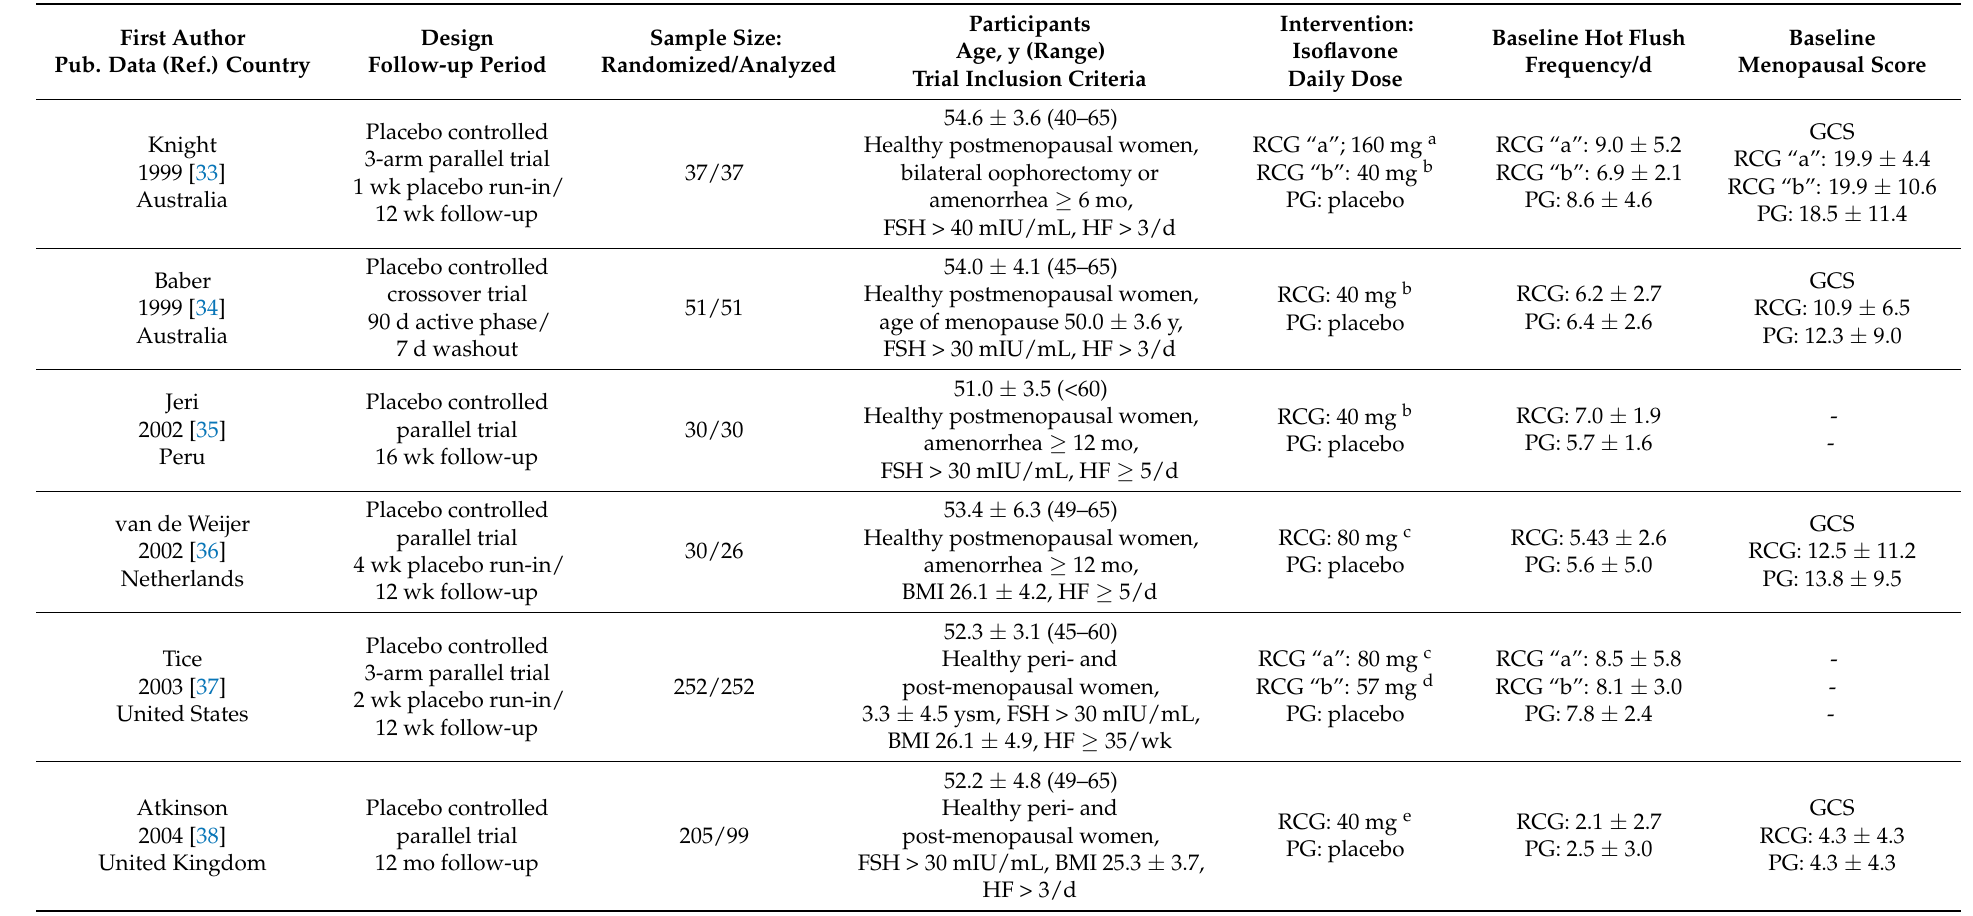
Table 1. Randomized controlled trials of Trifolium pratense for alleviating menopause symptoms: studies’